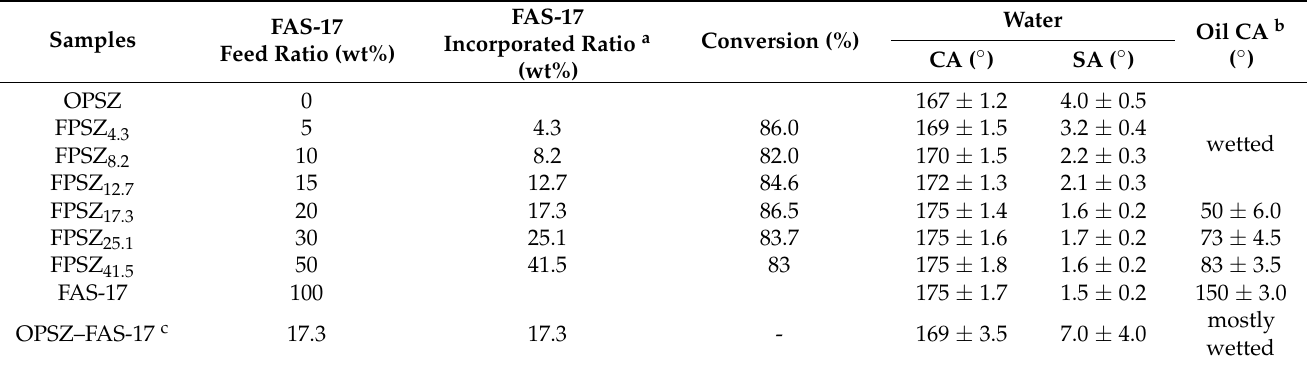
Table 1. Wettability properties of the OPSZ-, FPSZ-, FAS-17–, and OPSZ–FAS-17